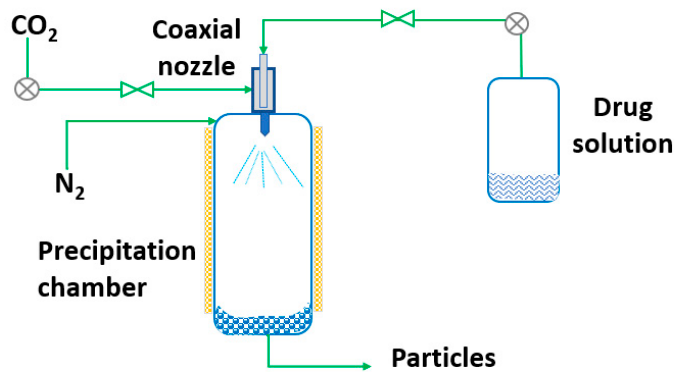
Figure 9. Supercritical-Enhanced Atomization (SEA) process (adapted from Padrela et al. [15]). Supercritical Fluid-Assisted Atomization (SAA)/Supercritical CO 2 -Assisted Spray-Dry- ing (SASD)